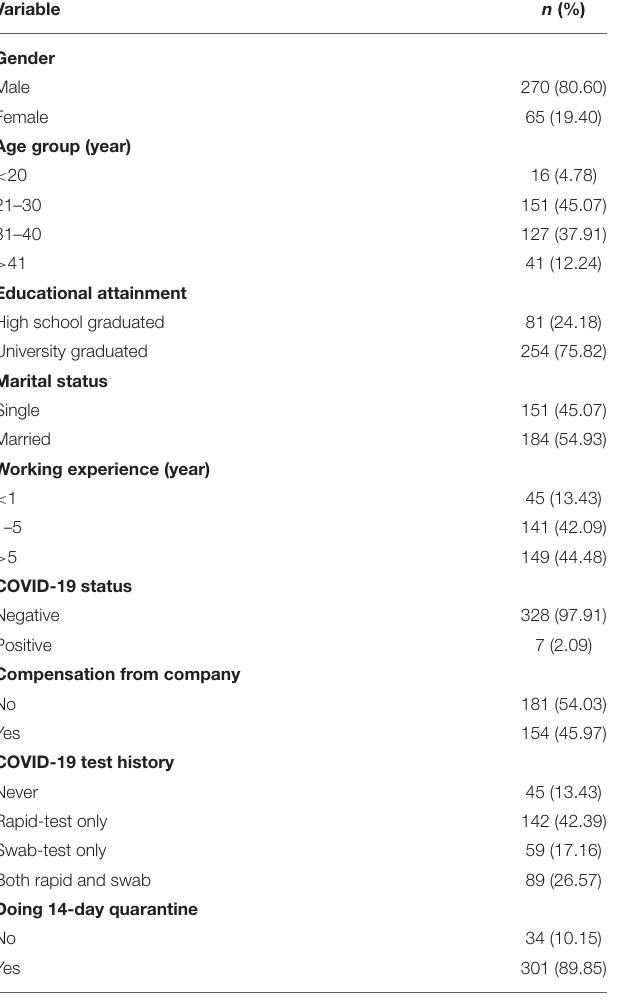
TABLE 1 | Sociodemographic characteristics of Indonesian migrant workers and COVID-19 related experiences ( n = 335). Variable